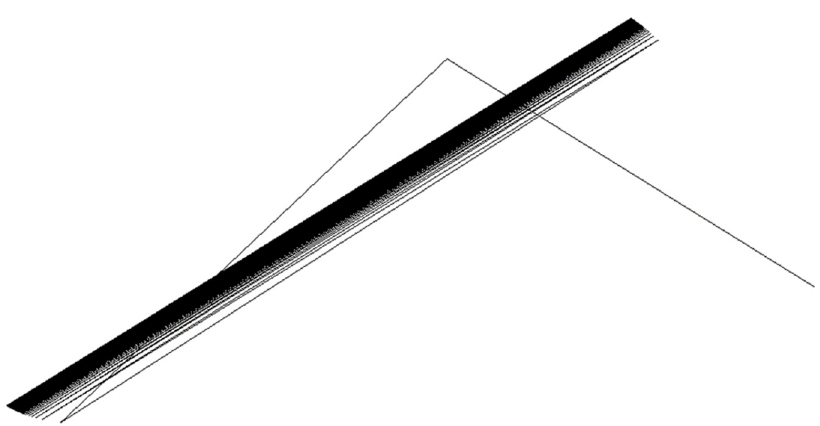
Figure 7. Trajectory of the particle in a two-dimensional chaotic model for the value of parameter, p = 0.6.